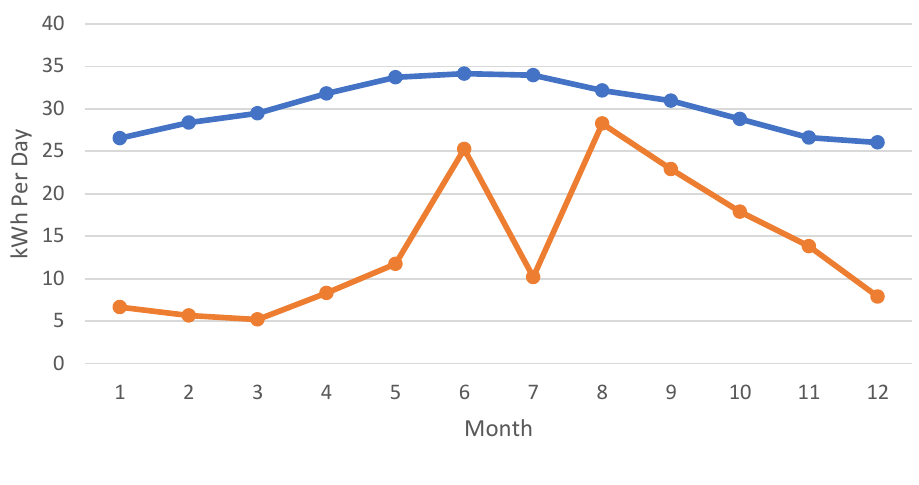
Figure 8. MPE vs. MPN (40% vs. 4 panels) .